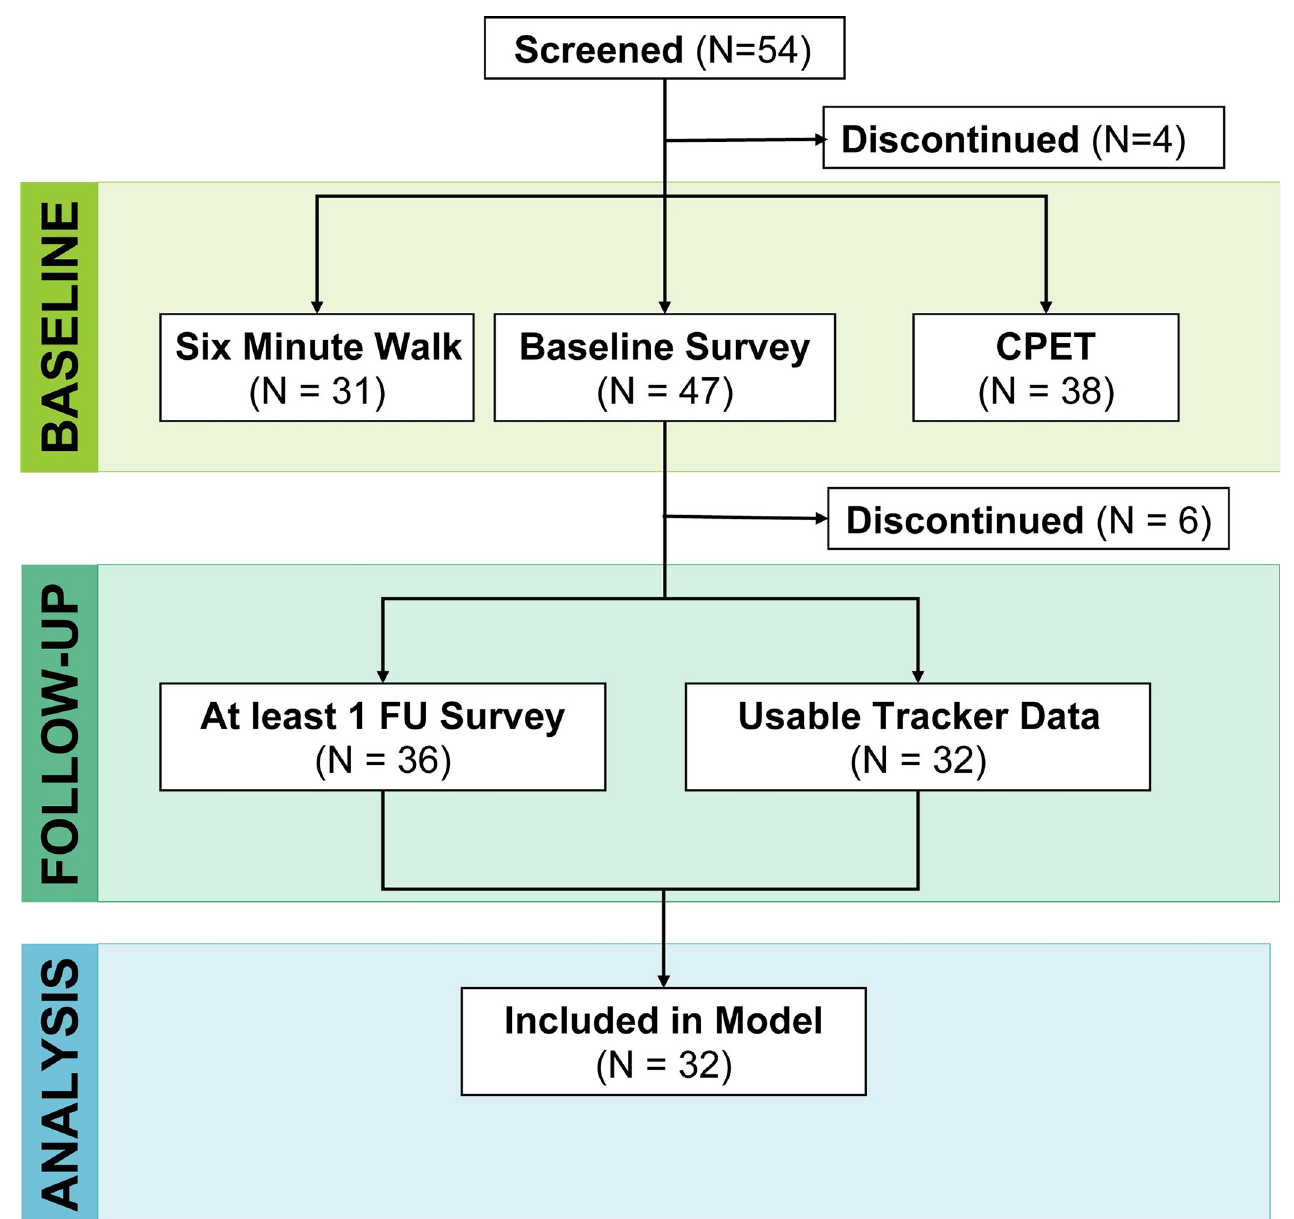
Fig 1. Study design and participant enrollment. Participants were initially screened and underwent baseline assessments (Baseline Survey, Six Minute Walk Test, Cardiopulmonary Exercise Testing) followed by fitness tracker data and follow-up surveys. 4 participants discontinued before baseline testing and 6 participants discontinued after completing baseline surveys. A total of 32 participants had survey data with tracker data for the corresponding time period and were included in the mixed-methods regression